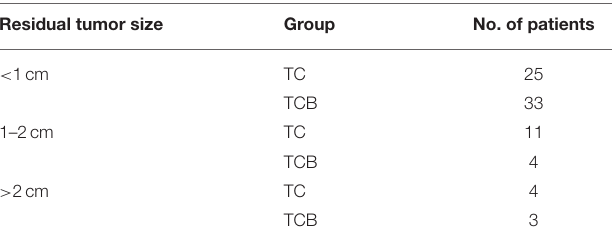
TABLE 2 | Diameter of residual tumor size in two